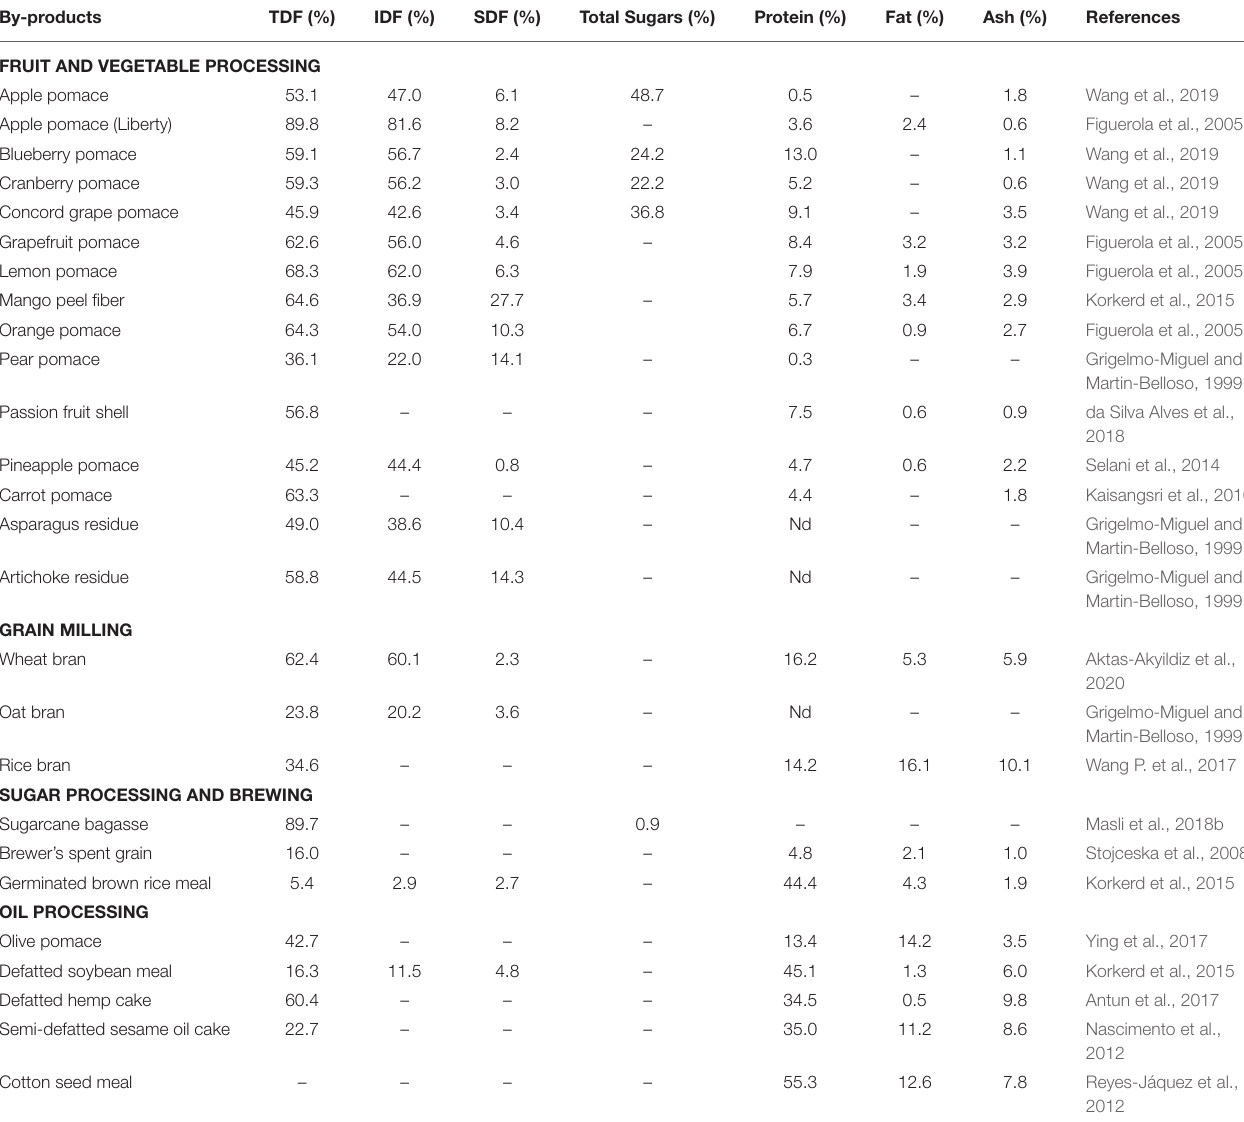
TABLE 1 | Chemical composition of selected